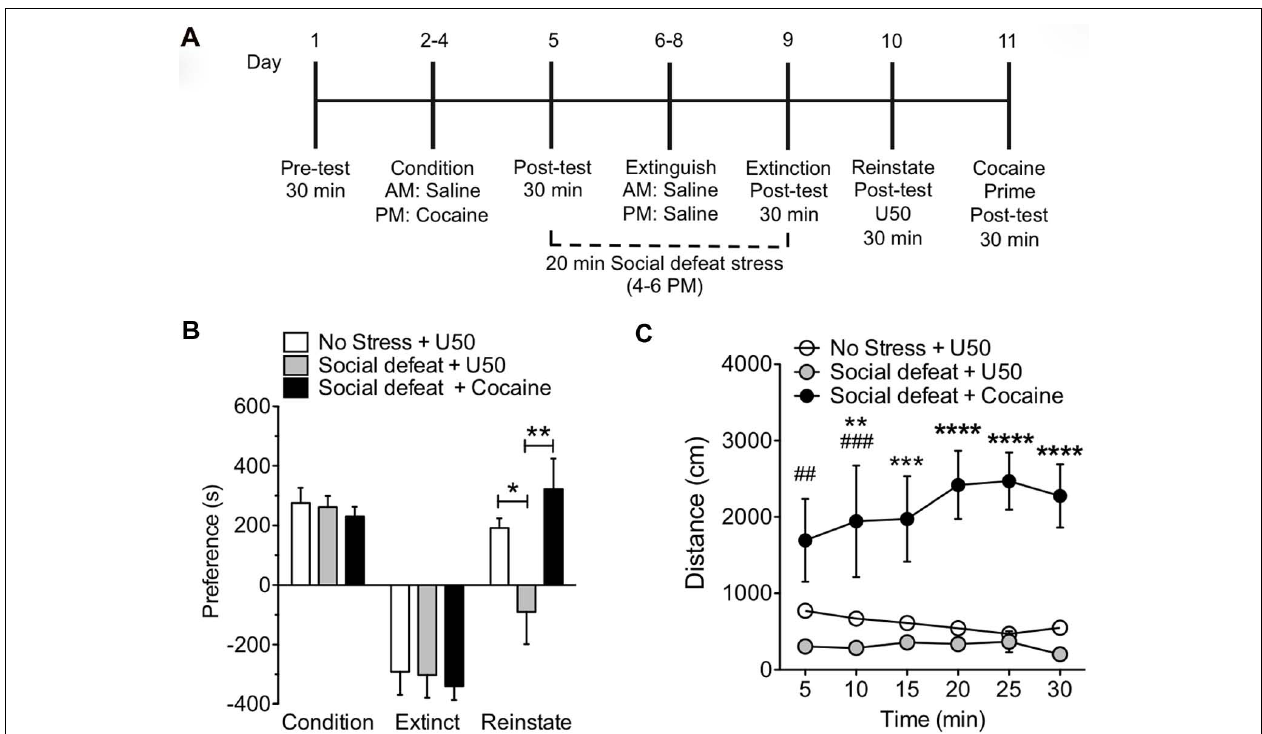
FIGURE 2 | Exposure to sub-chronic social defeat stress prevents U50,488-induced reinstatement of cocaine place preference. (A) Timeline of cocaine place preference-reinstatement experiment. (B) Cocaine preference scores (day 5) calculated as post-test minus pre-test on the cocaine-paired side (condition) and U50,488-induced (5 mg/kg, i.p.) reinstatement scores (day 10) of extinguished place preference (reinstate), calculated as reinstatement test day minus extinction post-test day. Groups are defined in the figures as their final reinstatement grouping (U50 = U50,488). Data show a significant attenuation in KOR-reinstatement following sub-chronic social defeat stress. Data represent the mean preference (s) ± SEM, n = 12–16 (* p < 0.05, no stress and U50,488 vs. social defeat stress and U50,488, ** p < 0.01, social defeat stress and